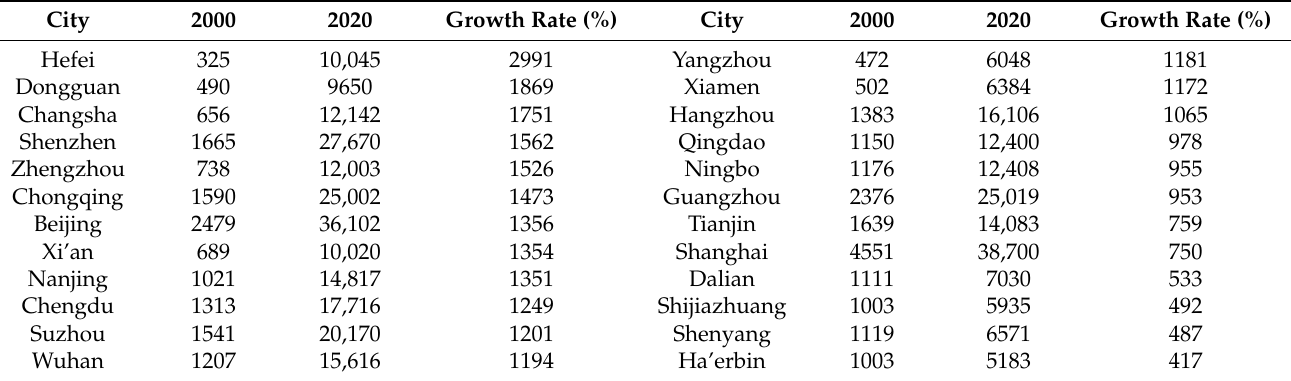
Table 1. GDP growth rate among major cities in China from 2000 to 2020 (unit: × 10 8